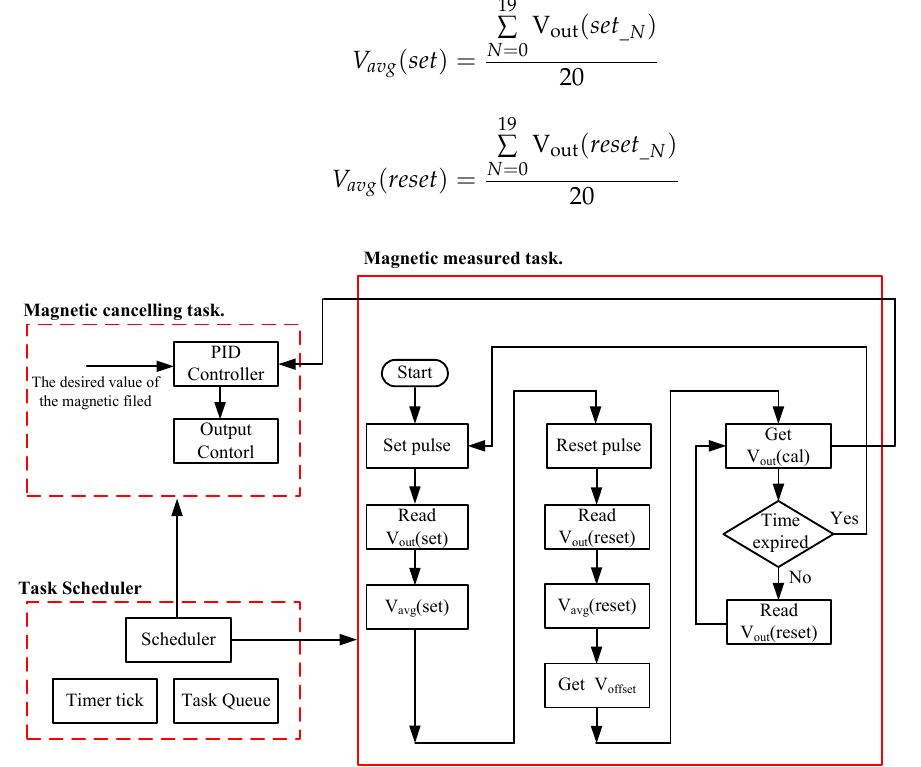
Figure 5. The software flow diagram of the AMCS.